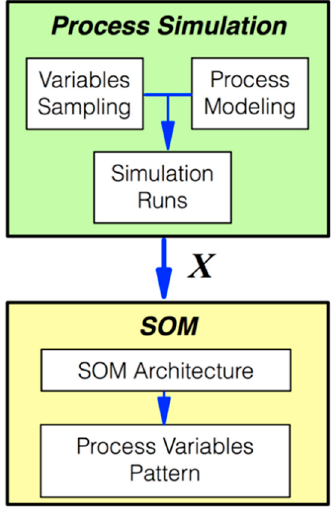
Figure 2. Schematic overview of using SOM as variables pattern recognition in simulated chemical processes. X is the set of all simulation variables values ( ξ n n ∈ [ 1 : N ] ) collected from each simulation run ( x j , j ∈ [ 1 : J ] ) and used as input dataset into SOM.